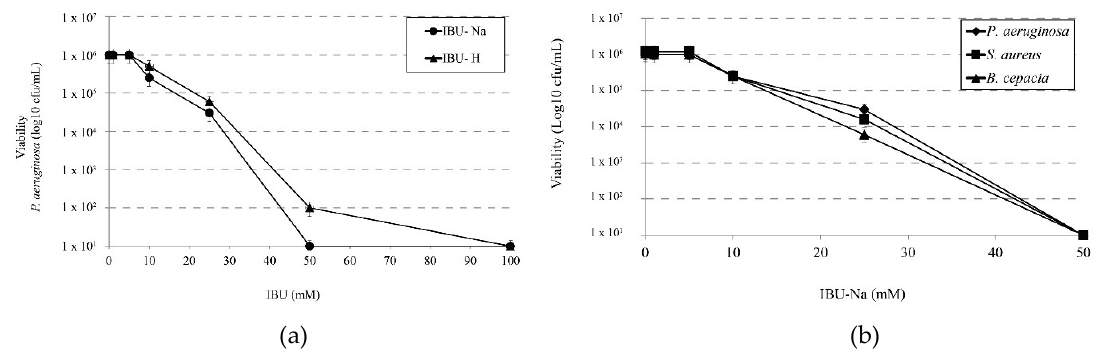
Figure 1. Minimum inhibitory concentration of IBU. ( a ) Bactericidal effect of increasing concentrations of IBU-Na and IBU-H (1, 5, 10, 25, 50, 100 mM) on the viability of P. aeruginosa at 1 × 10 6 cfu/mL after incubation for 24 h at 35 ± 2 ◦ C. ( b ) Susceptibility of S. aureus , B. cepacia and P. aeruginosa at initial concentration of 1 × 10 6 cfu/mL to increasing concentrations of IBU-Na (1, 5, 10, 25, 50 mM) incubated at 35 ± 2 ◦ C for 24